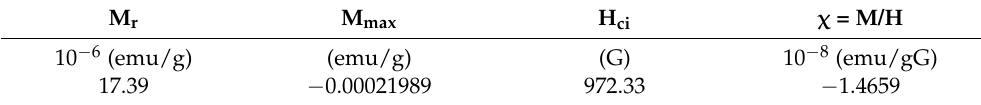
Table 1. Calculated value of susceptibility ( χ ), remanence (M r ), and magnetic coercivity (H ci ). M r M